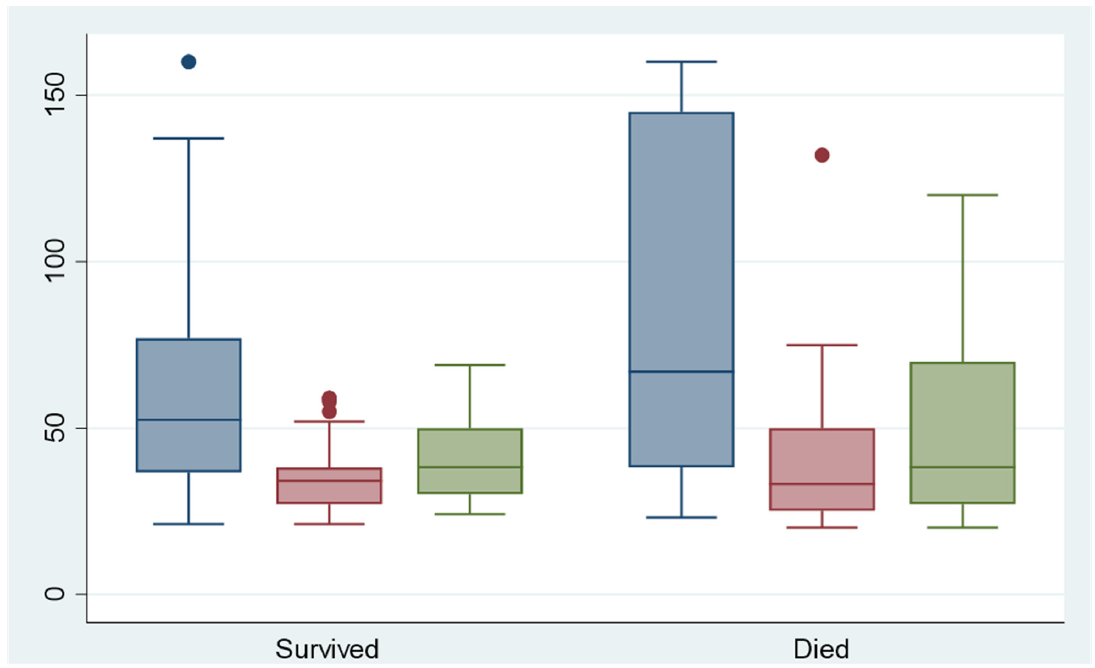
Figure 4. Serum PTT levels during angiography (blue), 12 h after angiography (red) and 24 h after angiography (green).